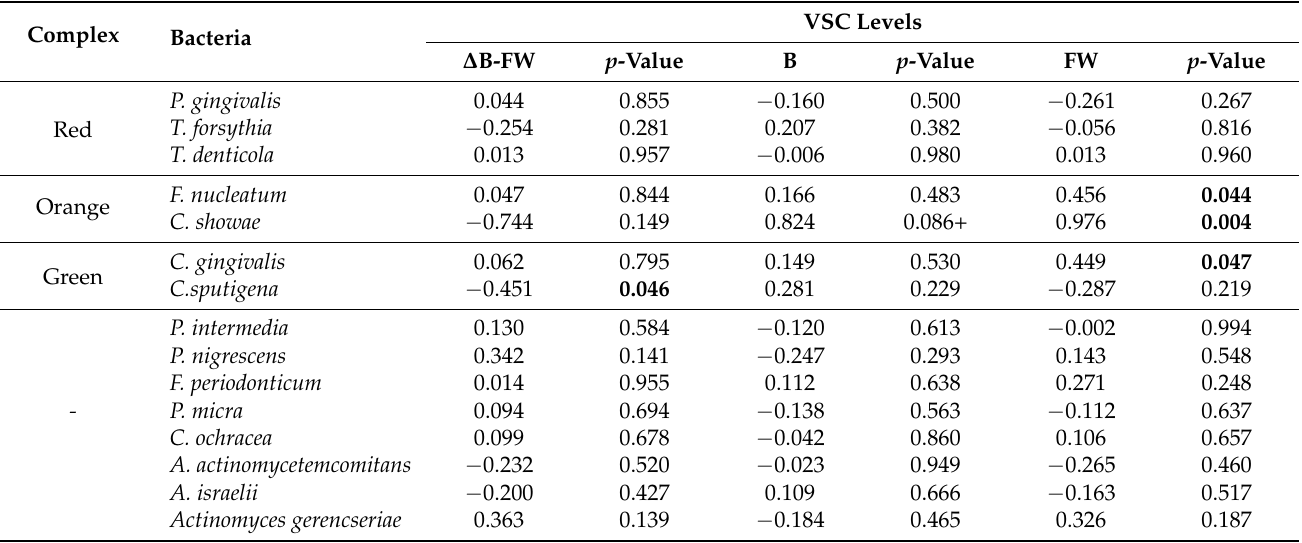
Table 3. Correlation of percentage microbiome with VSCs